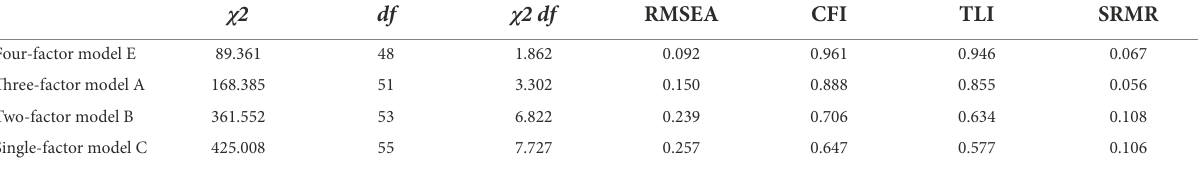
TABLE 3 Fitting indexes of four hypothetical model tests.